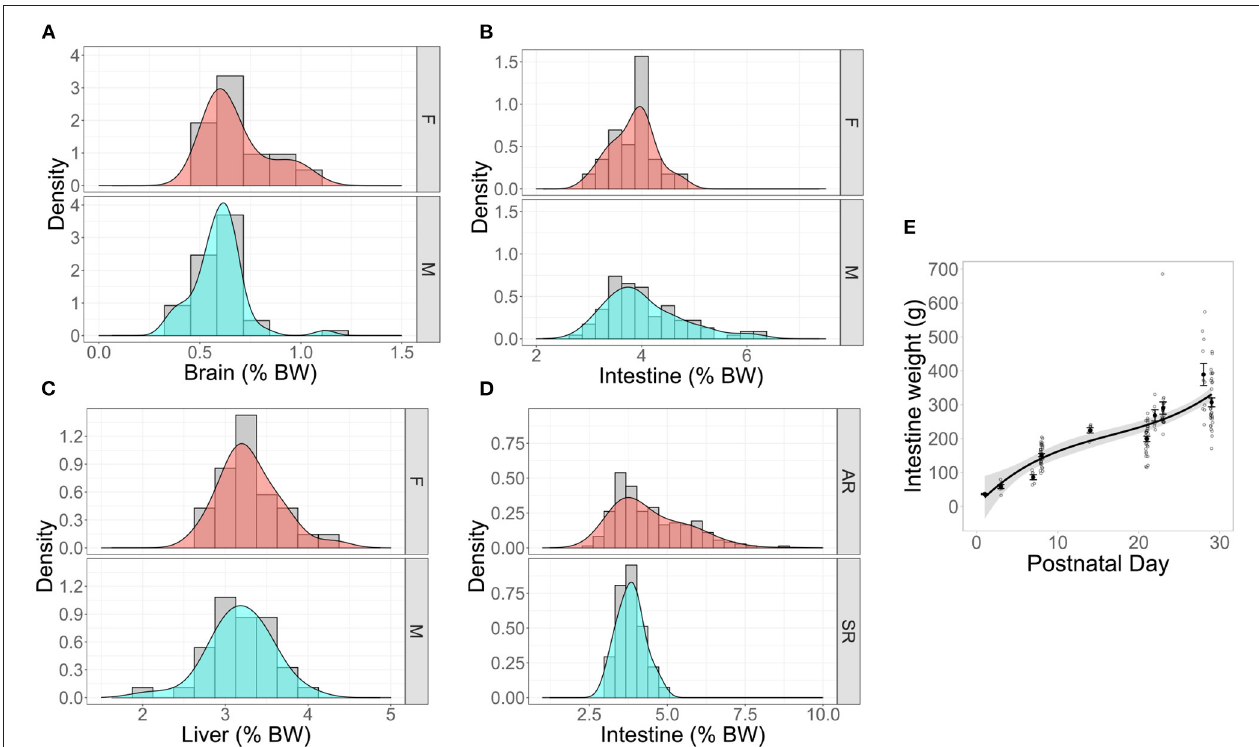
FIGURE 5 | Density plots with overlayed histograms showing smoothed distributions of organ weights of reference pigs stratified by (A–C) sex or (D) rearing environment. “Density” represents the function used to calculate the probability of getting a value between a range of values on the x-axis. The peaks of the density depict where values are concentrated over a given interval. The density plotted as percent of total body weight (BW) for (A) brain, n male = 20, n female = 8, (B) intestines n male = 60, n female = 15, and (C) liver n male = 8, n female = 8. (D) A density plot of percent intestinal growth in artifically-reared (AR) and sow-reared (SR) artificial reference pigs, n AR = 57, n SR = 18. (E) Absolute intestinal weight plotted as a function of PND (PND 1, n sample = 3; PND 3, n sample = 7; PND 7, n sample = 6; PND 8, n sample = 34; PND 14, n sample = 6; PND 21, n sample = 31; PND 22, n sample = 7; PND 23, n sample = 21; PND 28, n sample = 11; PND 29, n sample = 31) in artificially-reared reference animals indicates linear increase over